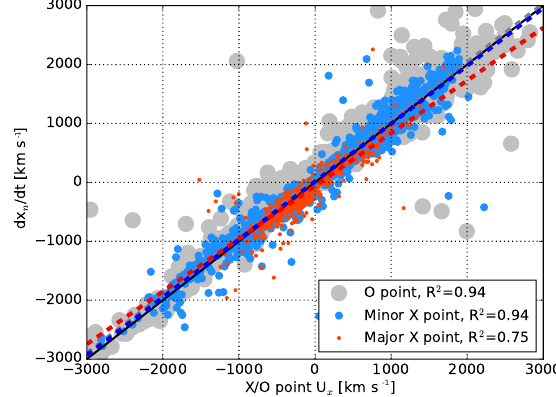
Figure 8. Earthward velocity of magnetotail plasma sheet O points, minor X points, and major X points as a function of x . The median values of positive and negative major X point velocities are indi- cated by the dashed horizontal lines.